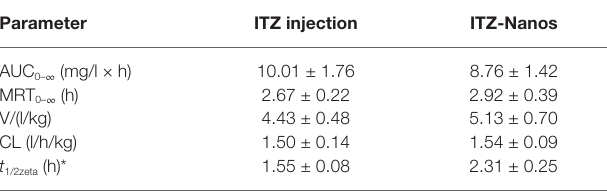
TABLE 2 | Comparison of the main PK parameters for two